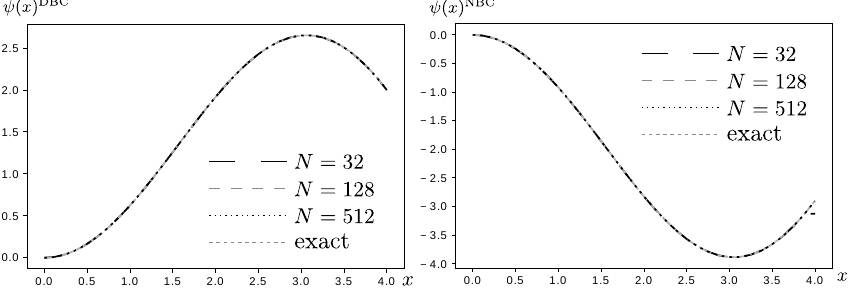
Figure 2. Left : solution to the DE given by Equation (57) with the initial conditions ψ ( 0 ) = 0 and ψ ( 4 ) = 2. Right : solution to the DE given by Equation (57) with the initial conditions ψ (cid:48) ( 0 ) = 0 and ψ (cid:48) ( 4 ) = 2. Table 6 analyzes the accuracy of the numerical solutions. Note: we made x 0 = 10 − 6 to avoid numerical divergences at x = 0. Table 6. Analysis of the accuracy of the two numerical solutions to Equation (57). The first two blocks use the conditions ψ ( 0 ) = 0 and ψ ( 4 ) = 2 and show the value of the maximum—exact value ψ DBC max = 2.6524822 . . . , its percentage error (PE) (from 0 t 100%), and mean square error (MSE) of the function along the domain [ 0,4 ] ; the first block uses the weight function, the second one does not. The block below shows something similar for the conditions ψ (cid:48) ( 0 ) = 0 and ψ (cid:48) ( 4 ) = 4 and focus on = − 3.88574186 . . . using the weight function—remember the global minimum—exact value ψ NBC min that for NBC the formalism with the weight function is